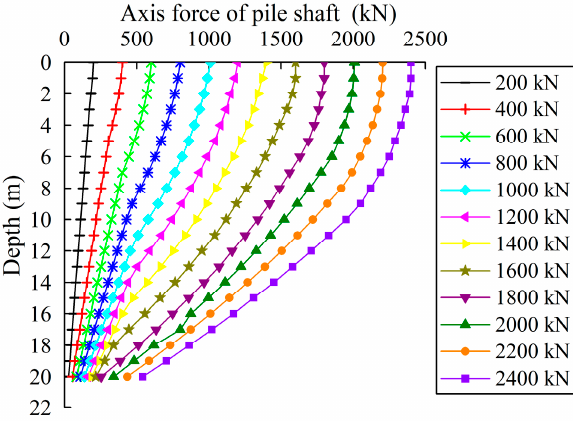
Figure 9. Distribution of axial force for open-ended pipe.